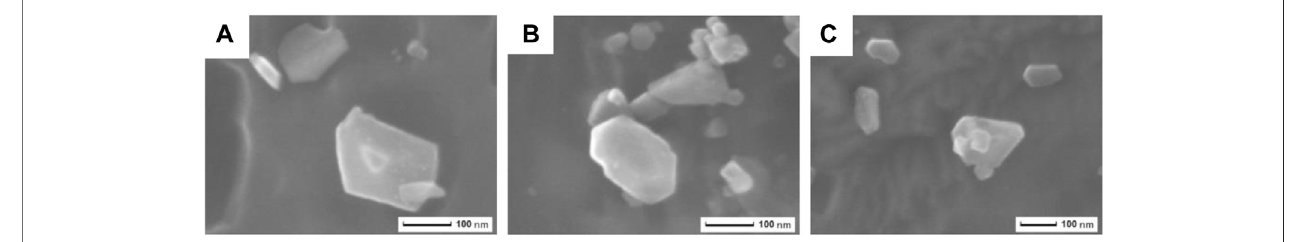
FIGURE 4 | SEM images of TiB 2 particles at higher magni fi cation (A) region 1 (B) region 2 (C) region 3.